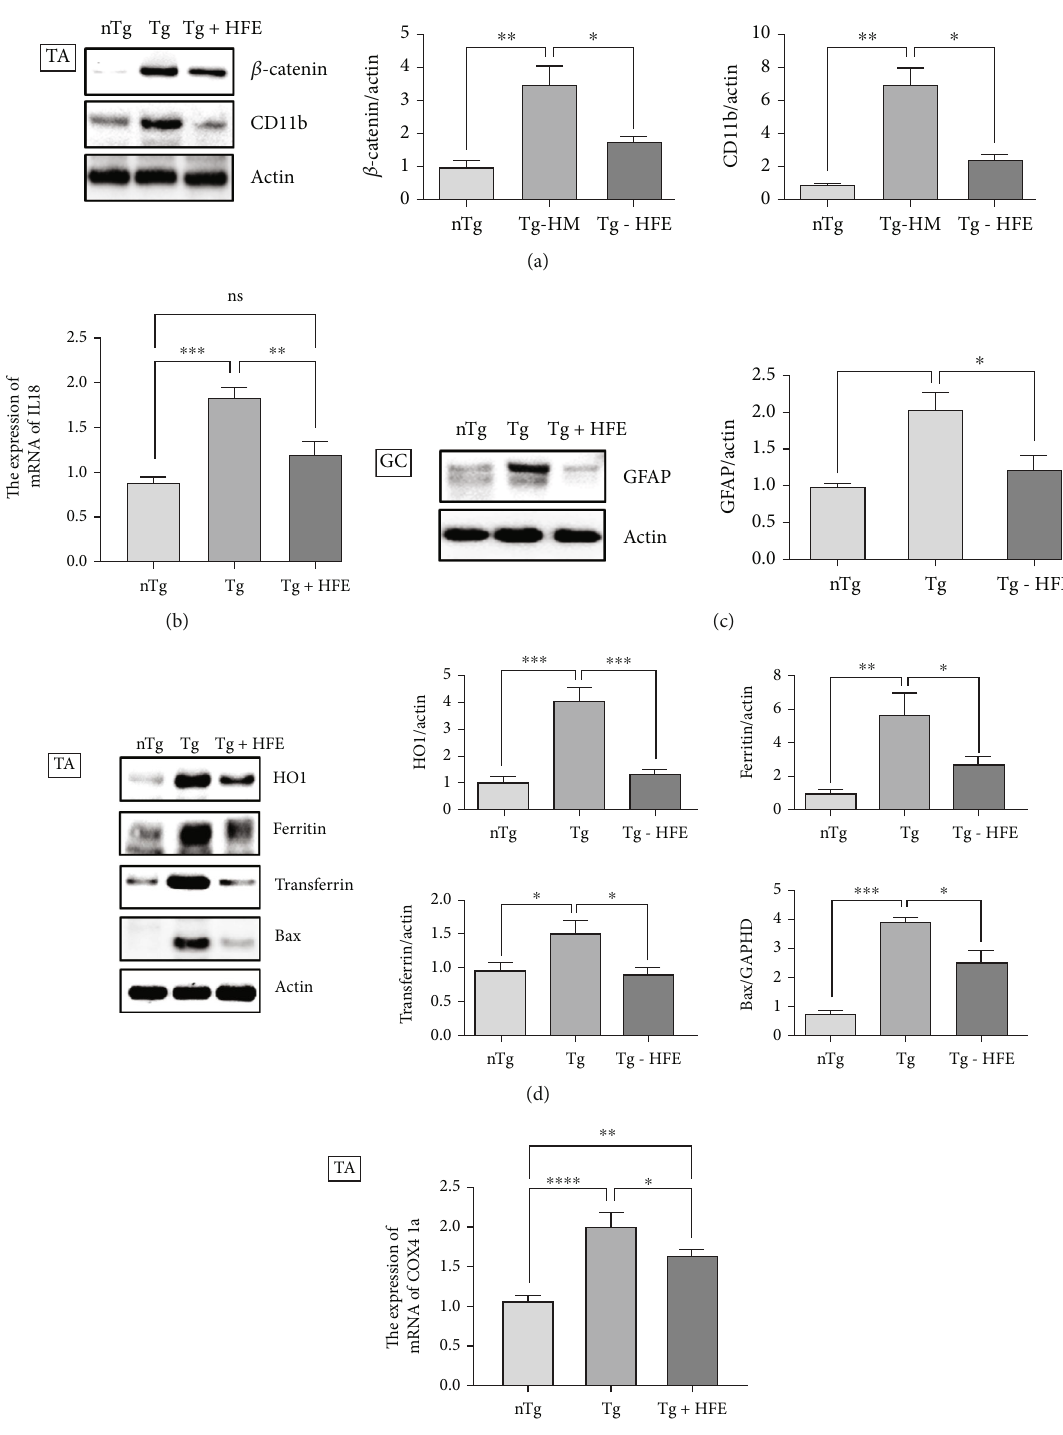
Figure 3: Herbal formula extract (HFE) reduced the expression of in fl ammatory proteins and oxidative stress-related proteins in the tibialis anterior (TA) and gastrocnemius (GC) of hSOD1 G93A mice. (a) Representative immunoblots of in fl ammatory proteins and their quanti fi cation in the TA of nontransgenic (nTg), transgenic (Tg), and HFE-Tg mice. n =3 – 4 per group. (b) mRNA expression level of IL18 in the TA of each group. n =4 – 5 mice per group. (c) Representative blot and quanti fi cation of the level of GFAP protein in the GC of nTg, Tg, and HFE +Tg mice. n =3 – 4 per group. (d) Levels of oxidative stress-related proteins (HO1, ferritin, transferrrin, and BAX) were reduced by HFE treatment in the TA of hSOD1 G93A mice. n =3 – 4 per group. (e) mRNA expression level of COX IV 1a in the TA of each group. n =4 – 5 mice per group. ∗ p < 0 : 05 , ∗∗ p < 0 : 01 , ∗∗∗ p < 0 : 001 . nTg: nontransgenic mice, Tg: transgenic mice, Tg +HFE: HFE-treated transgenic